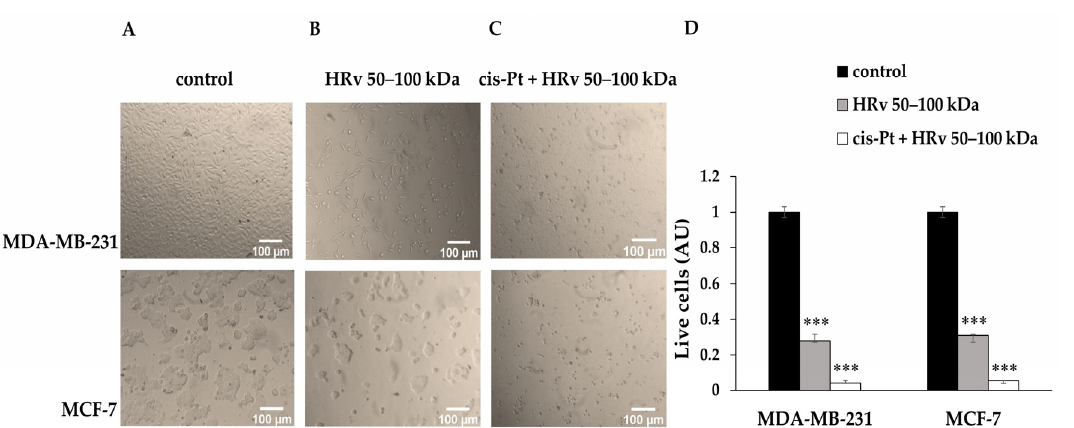
Figure 6. Microscopic images of breast cancer cell lines MDA-MB-231 and MCF-7. ( A ) Control, non-treated cells; ( B ) Cells treated with IC 50 of hemolymph from R. venosa (Mw 50–100 kDa); ( C ) Cells treated with cisplatin at IC 50 in combination with hemolymph fraction from R. venosa with Mw 50–100 kDa at IC 25 ; ( D ) Quantification of live cells determined after Trypan Blue staining, calculated as arbitrary units (AU) normalized to the number of live cells in the untreated control. For statistical analysis, Dunnett’s multiple comparisons test in ordinary two-way ANOVA was used to compare the mean of each column with the mean of the control column. Probability values were *** p < 0.005, Bar graphs represent the means of four independent experiments.